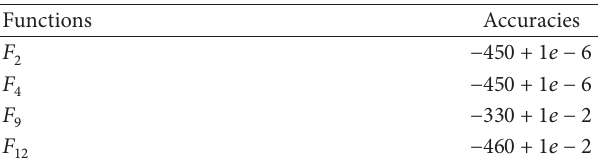
Table 2: Accuracies of